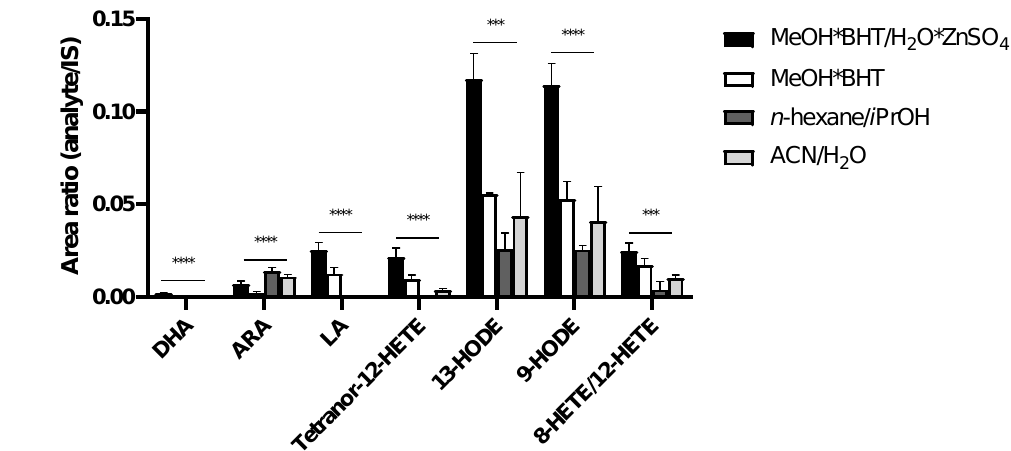
Figure 2. Comparison of precipitation solutions using pooled EV samples. Significant higher signals, expressed as peak area ratios of analyte to IS, for MeOH*BHT/H 2 O*ZnSO 4 (80:20 v / v ). Measurements performed as triplicates. Statistics: one-way ANOVA with follow-up multiple comparison test (Dunnett); p ≤ 0.001 (***), p ≤ 0.0001 (****). ACN — acetonitrile; ARA — arachidonic acid; BHT — bu-